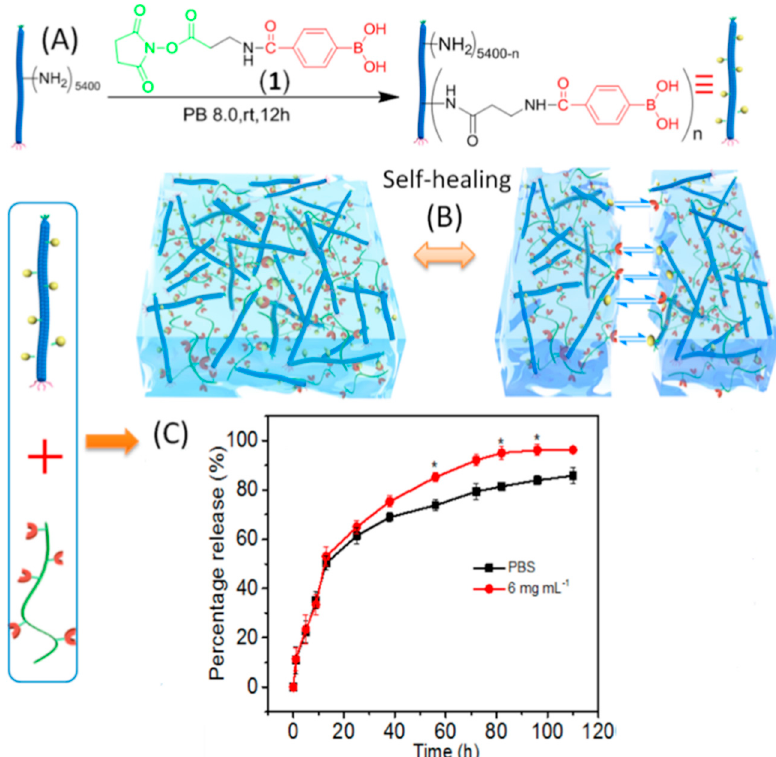
Figure 6. Schematic representing ( A ) the preparation of viral bioconjugates of M13 viruses with low-pKa phenylboronic acid derivative (PBA-M13) and ( B ) fabrication of dynamic hydrogels via binding of PBA-M13 with multiple diol-containing polymers and demonstration of self-healing behavior. ( C ) Glucose responsiveness-regulated insulin release behaviors. FITC-insulin was loaded into the hydrogel and then placed into PBS bu ff er with or without glucose. The released FITC-insulin was monitored by fluorescent measurements. The asterisks represent the statistical significance, which is calculated by multiple t tests-one per row: * p < 0.05, ** p < 0.01, *** p < 0.001. The hydrogels consist of 1 wt % PBA-M13 and 0.15 wt % PVA (Adapted with permission from [237], Copyright American Chemical Society,